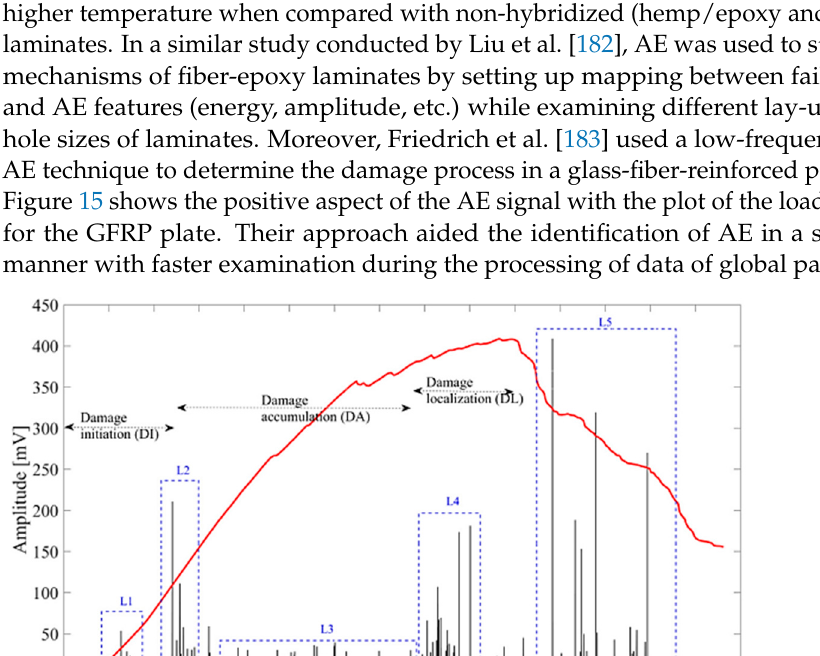
Figure 14. Use of AE data acquisition software when the specimen is subjected to flexural loading [181] (Reprinted/adapted with permission from Elsevier Ref.5457241208643 Copyright 2019).